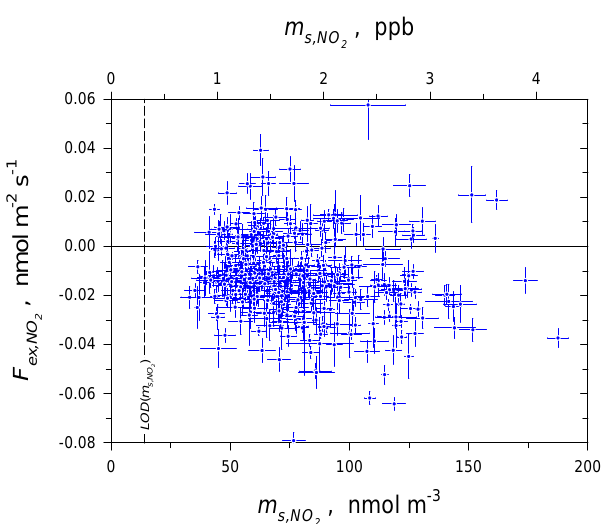
Figure 3. NO 2 exchange flux density ( F ex,NO2 ) vs. NO 2 concentration measured at the outlet of 2 ) vs. NO 2 concentra- Fig. 3. NO 2 exchange flux density ( F ex , NO 2 the dynamic plant chamber ( m s,NO2 ) of Picea abies 1 over the entire measuring period. Data 3 tion measured at the outlet of the dynamic plant chamber ( m s , NO were filtered for daytime conditions, period of possible advection and significance of 4 of Picea abies 1 over the entire measuring period. Data were filtered for daytime conditions, period of possible advection and signifi- Δ m NO2 = ( m a,NO2 - m s,NO2 ). F ex,NO2 were calculated according to Eq. (1), their standard errors 5 = (m − m cance of 1m NO according to Eq. (7). 6 a ,NO 2 s , NO 2 ) . F ex , NO 2 were calculated 2 according to Eq. (1), their standard errors according to Eq. (7).